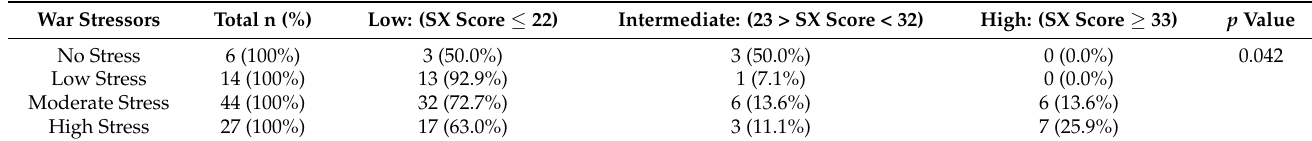
Table 2. SX score and war stress score